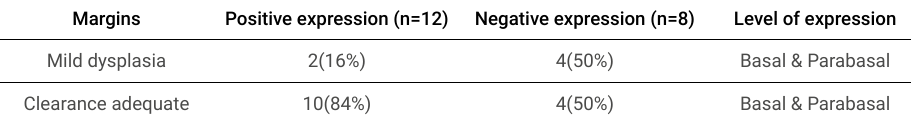
Table 4. Expression of p53 according in the resected surgical apparently clear